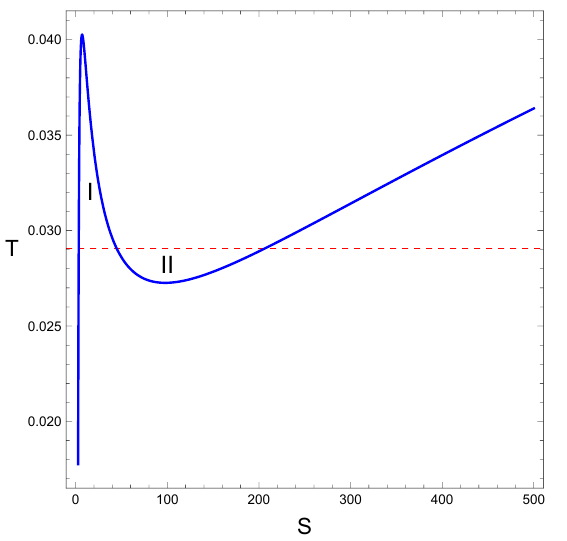
Figure 2 . Maxwell’s equal area law in the bulk. The phase transition temperature T = T (cid:3) is the one at which Areas I and II bounded by the isocharge curve in the ( T; S ) plane are